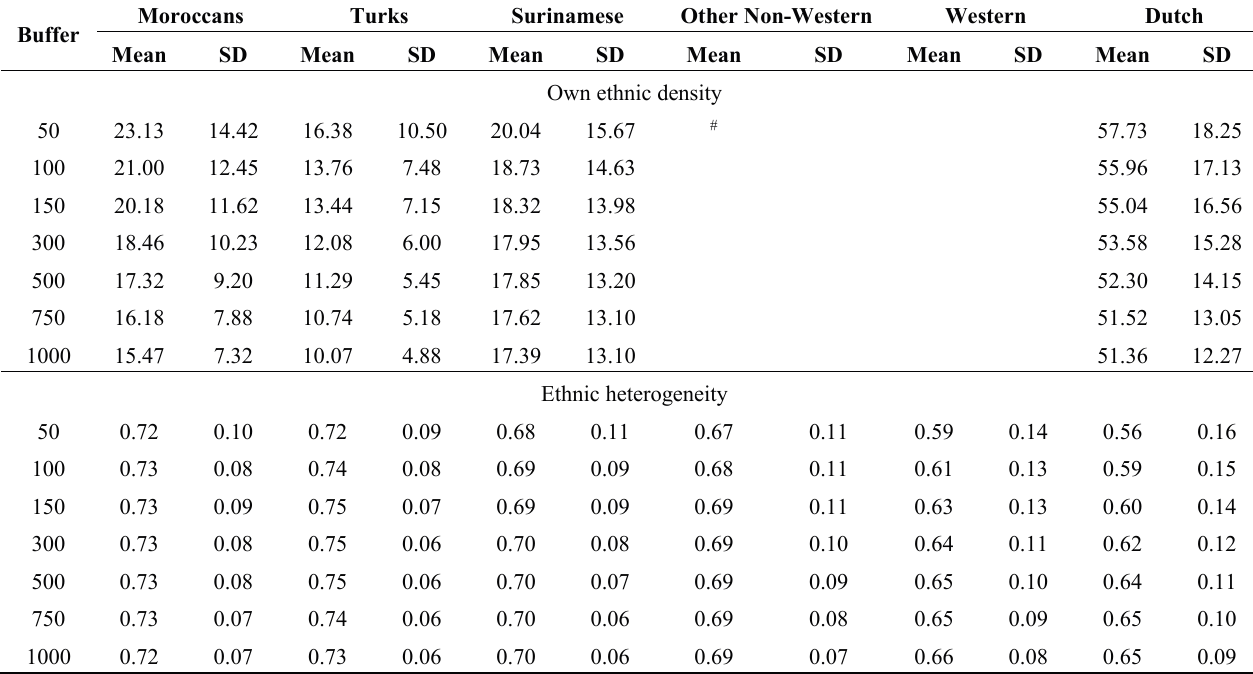
Table 2. Mean and variation of own ethnic density and ethnic heterogeneity (Herfindahl) per ethnic group and spatial scale (buffer